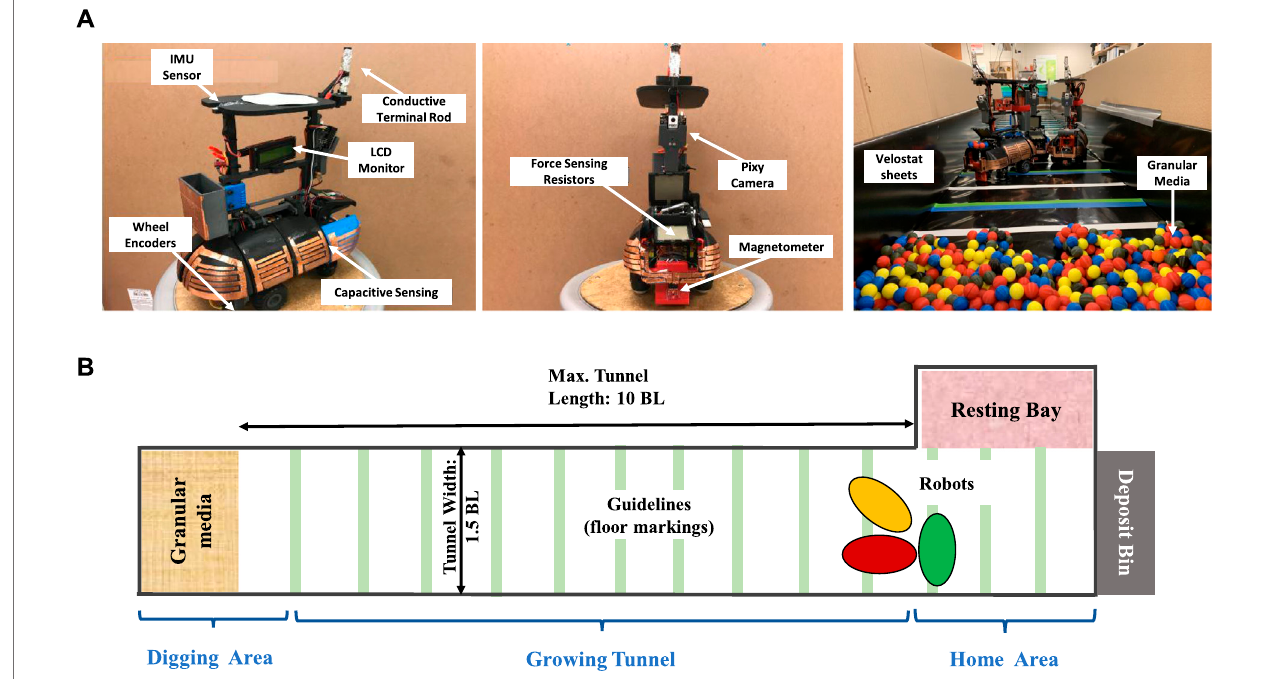
FIGURE1| Experimental apparatusconsisting ofrobots andatunnel. (A) Components ofanantrobot (twoleftimages):InertiaMeasurement Unit(IMU)sensorfor absoluteorientation;Wheelencodersforlocalizationviarobotodometry/deadreckoning;Capacitivetouchsensorshellsfordetectingcollisions;Forcesensitiveresistors for gripper tactile feedback, Magnetometer for detecting pellets and Digging Area; Pixy camera for tunnel navigation and localization; Terminal rod for charging and detection of Home area. In the tunnel (rightmost image): Velostat sheets for lining the tunnel to distinguish robot-robot collision (copper-copper) from robot-wall collision(copper-velostat);Granularmediatosimulatemodelcohesivesoilexcavatedbyants (B) Schematicdiagramofthecon fi nedtunnel:arobotstartsfromtheHome Area, decides whether to enter the tunnel and excavate some pellets, or decides to go to the Resting Bay to avoid interference at the tunnel entrance.